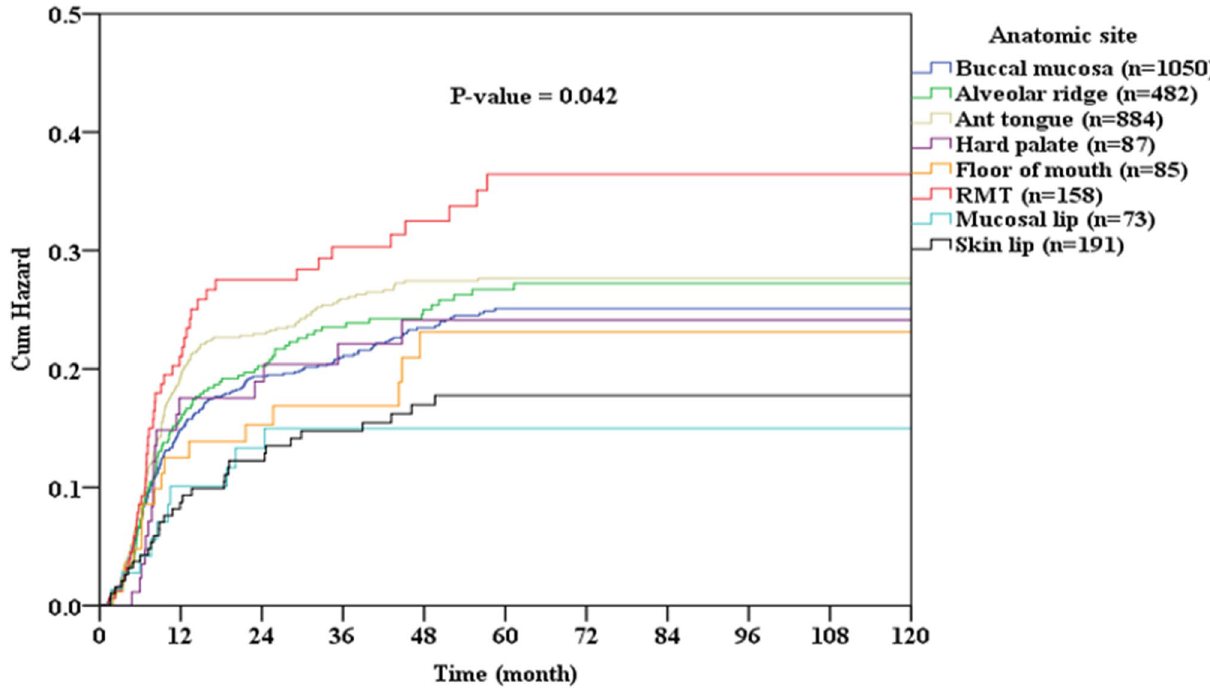
Figure 1. Cumulative recurrence rate oral cavity squamous cell carcinoma (OSCC) according to location of disease.